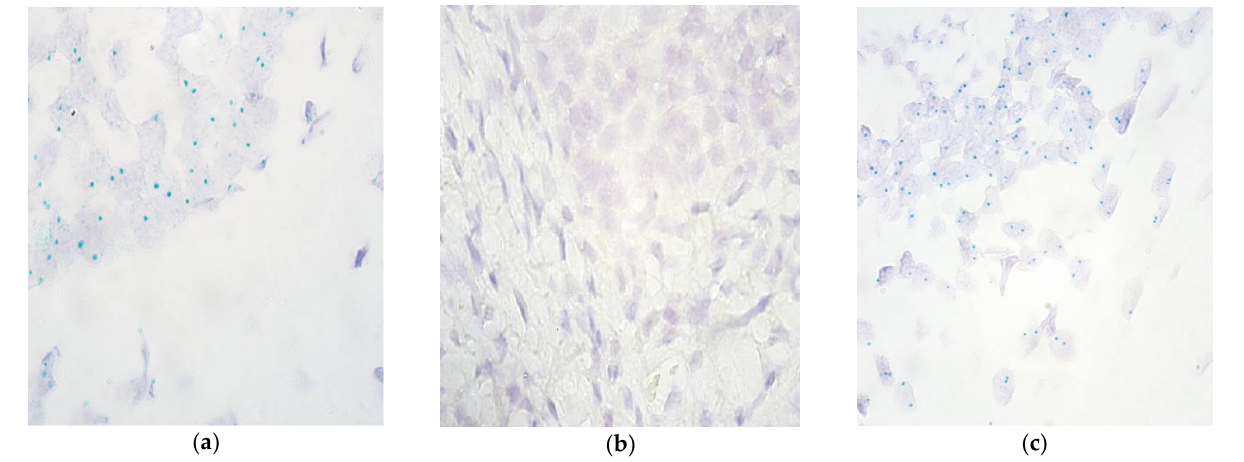
Figure 2. Chromogenic in situ hybridization micrographs of FGFR2 in cleft-affected lip and palatine tissue and control subject at 1000× magnification, using immersion oil. ( a ) Numerous (+++) gene signals in lip epithelium and moderate amount (++) of gene copies in lip connective tissue in a 3-month-old patient. ( b ) No (0) gene signals in palatine epithelium and connective tissue in a 15-month-old patient. ( c ) Numerous (+++) gene signals in the control group epithelium of a 7-year- old